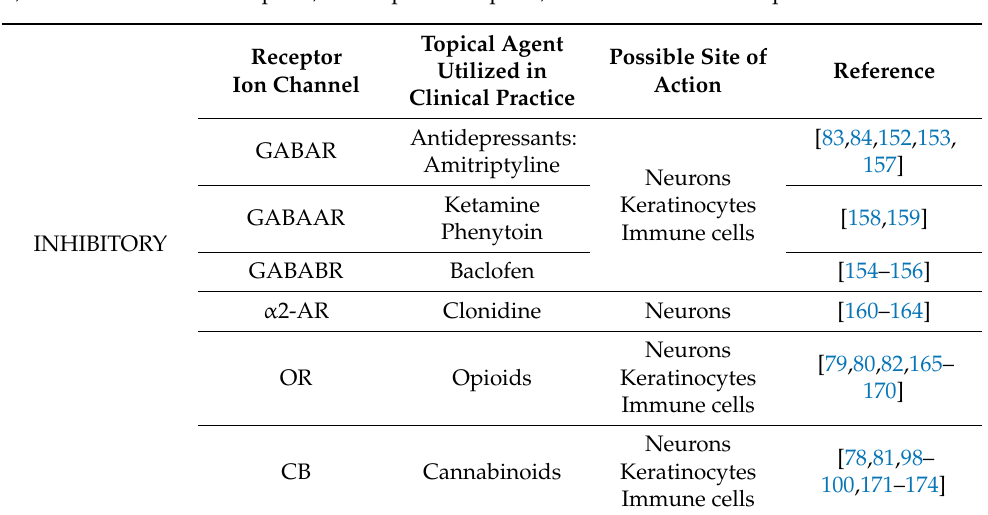
Table 2. Receptors, ion channels with inhibitory mode of action, involved in modulation of NP, potentially targeted by topically administered treatments. Possible site of action of topical agents, addressing given molecular target. Abbreviations: GABAR—gamma-aminobutyric acid receptors, GABAAR—gamma-aminobutyric acid receptors A, GABABR—gamma-aminobutyric acid receptors B, α 2-AR— α 2 adreno receptors, OR—opioid receptors, CB—cannabinoid